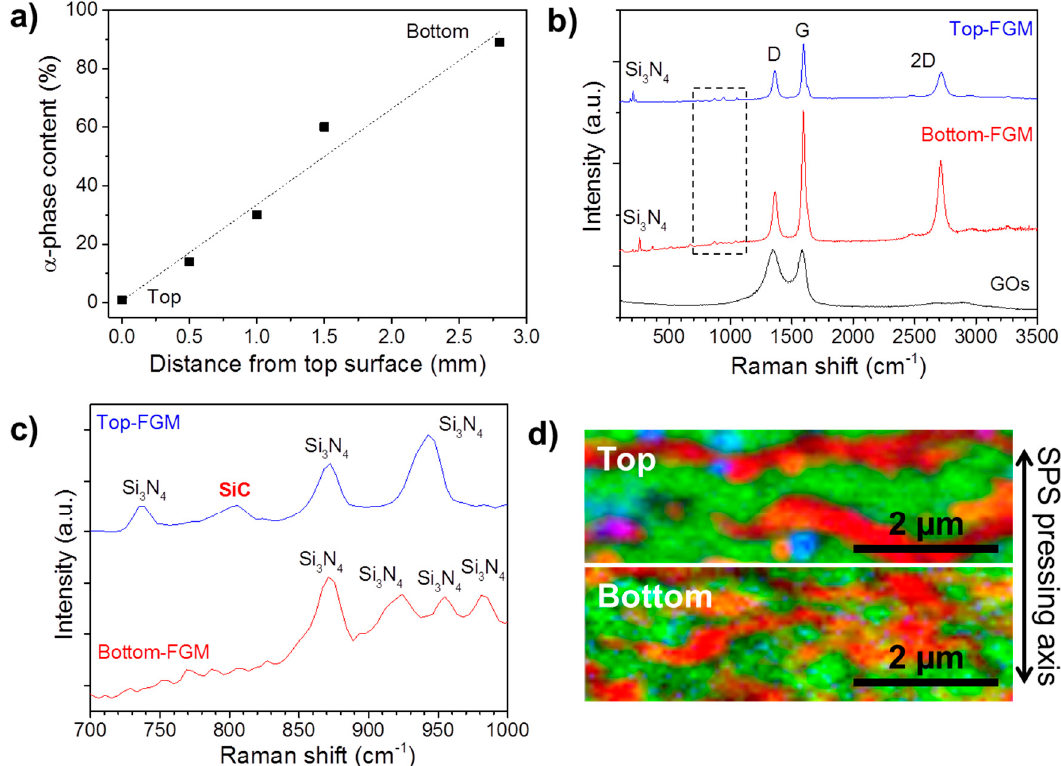
Figure 2. ( a ) α -phase Si 3 N 4 content along the cross-section of the sintered Si 3 N 4 /GOs specimen. ( b ) Average Raman spectra for pristine GOs and at the bottom and top areas of the FGM and ( c ) zoom of the dashed region. ( d ) False colored Raman images at the bottom and top surfaces of the FGM by merging the intensity maps of the G-band of rGOs (red), TO of SiC (blue), and Si 3 N 4 peaks in the interval of 175–250 cm − 1 (green).